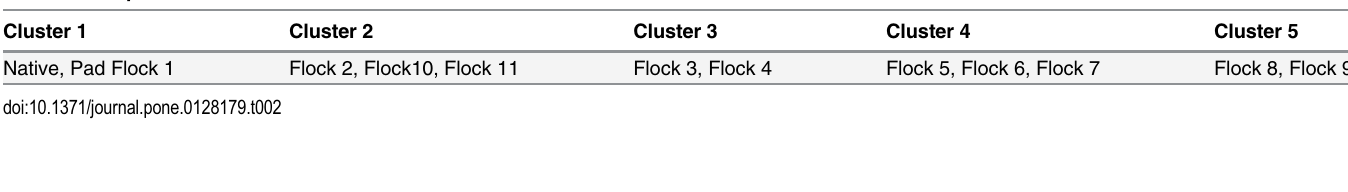
* The parameters with the largest in fl uence for each canonical variate are in